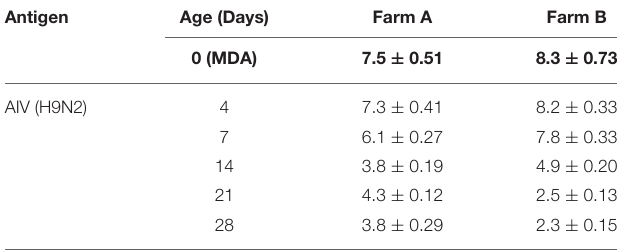
TABLE 2 | AIV H9N2 HI GMT results for different field